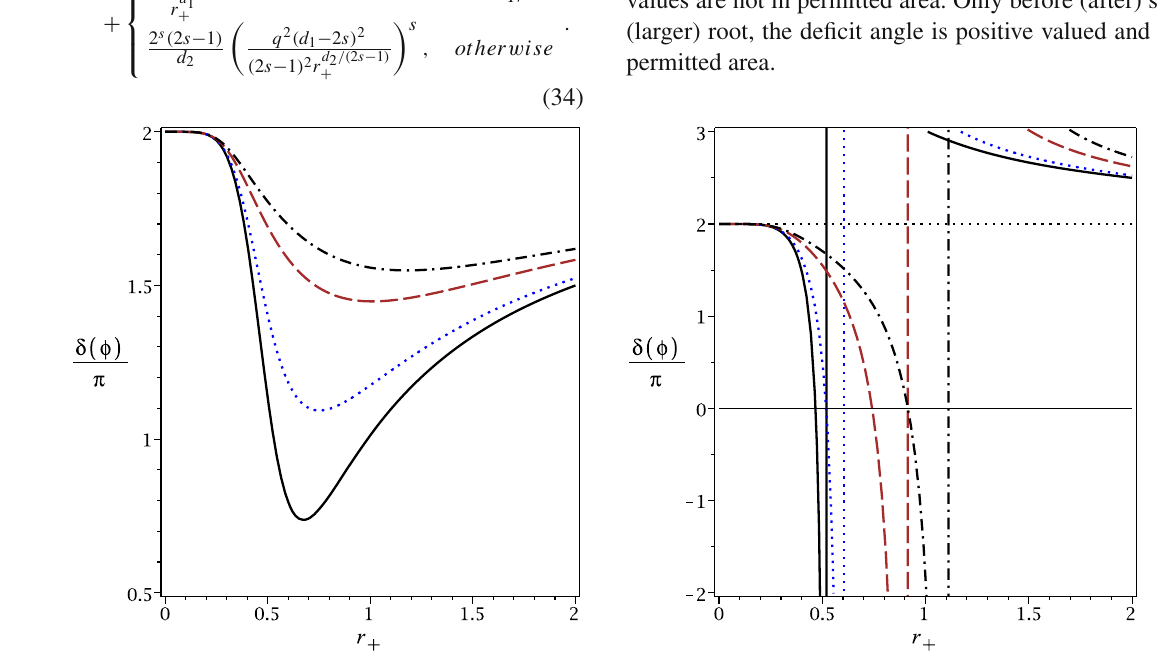
Fig. 1 PMI solutions: δ (φ) versus r + for q = 0 . 1, c = c 1 = c 2 = c 3 = c 4 = l = 1, d = 5 , s = 0 . 9, m = 0 (continuous line), m = 0 . 4 (dotted line), m = 0 . 8 (dashed line) and m = 1 (dashed-dotted line). Left diagram: (cid:3) = − 1; Right diagram: (cid:3) =